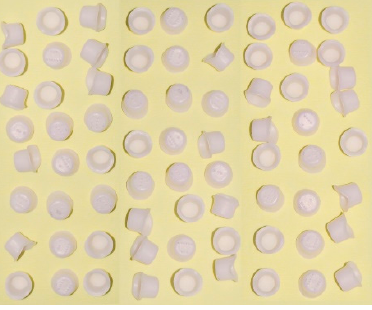
Figure 5. A total of 72 copings were milled according to test coping produced in order to evaluate the right fit.